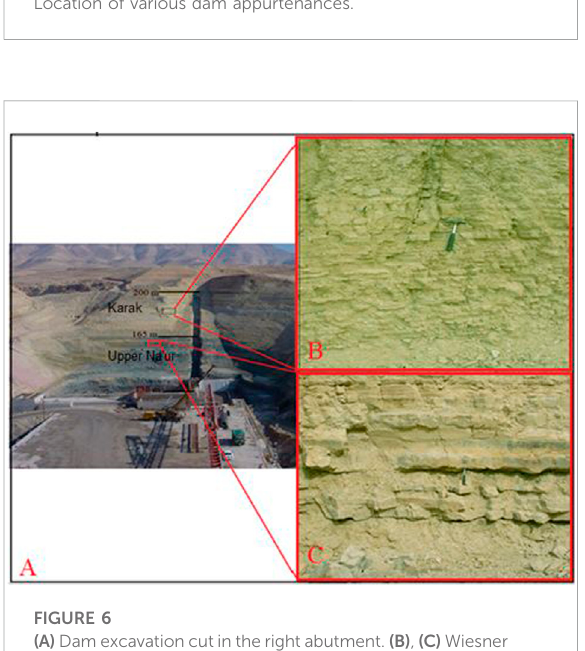
FIGURE 6 (A) Dam excavation cutintherightabutment. (B) , (C) Wiesner pictures of discontinuities.